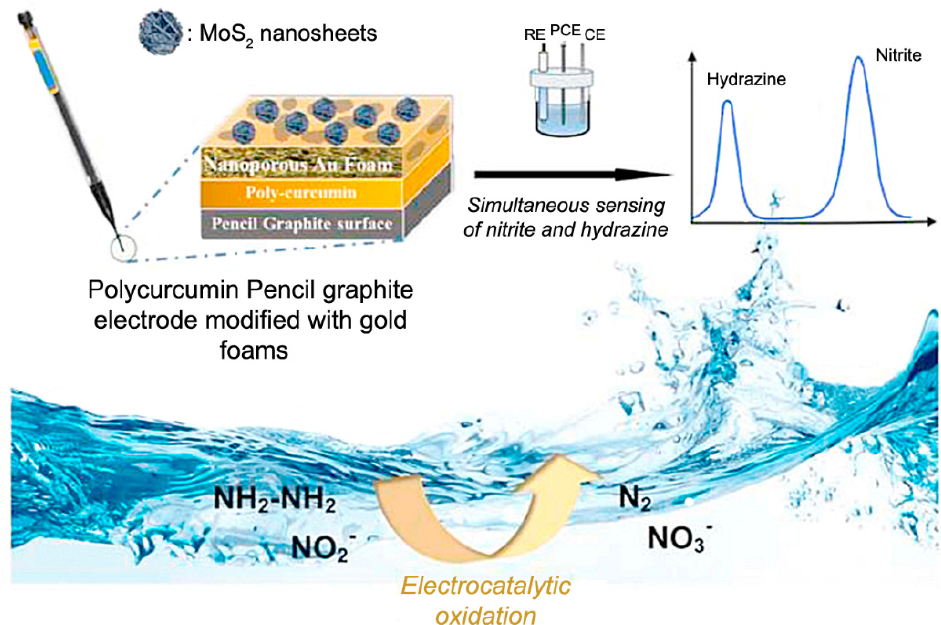
Figure 16. Schematic representation of the sensor based on the polycurcumin/gold foam decorated by molybdenum disulfide nanosheets and analytical application. Reprinted from [95] with permission from Elsevier.